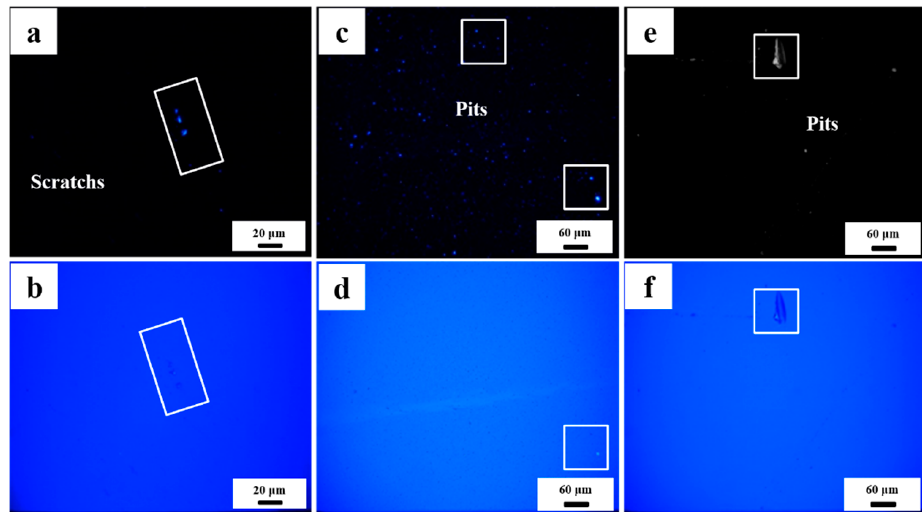
Figure 3. Scattered dark ( a , c , e )/light ( b , d , f ) field imaging of crystal surface defects after fine polishing.